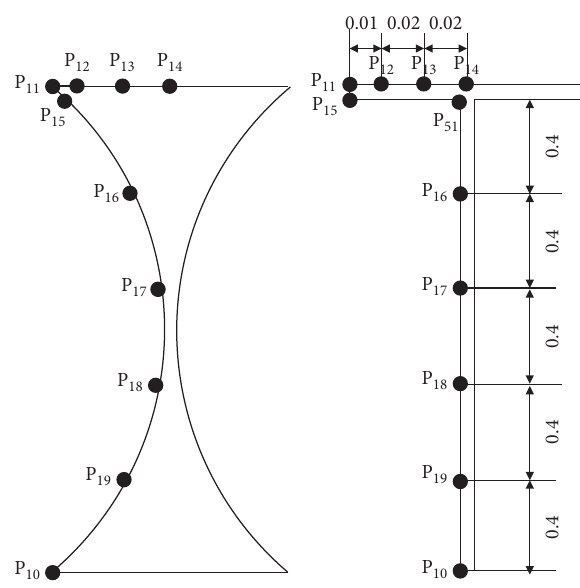
Figure 13: Layout of stress measurement points (unit: